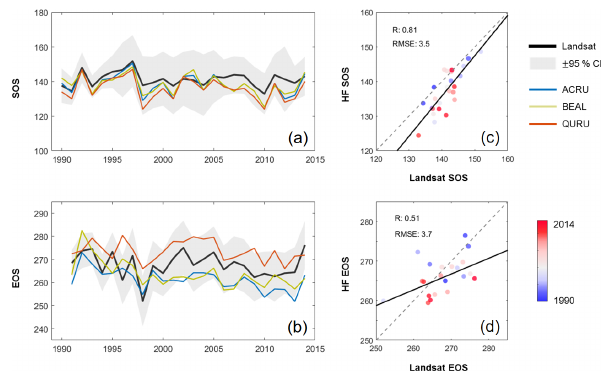
Figure 8. Annual dynamics of the start of season (SOS) (a) and the end of season (EOS) (b) derived from Landsat and Harvard For- est (HF) observations and their scatter plots of SOS (c) and EOS (d) over the